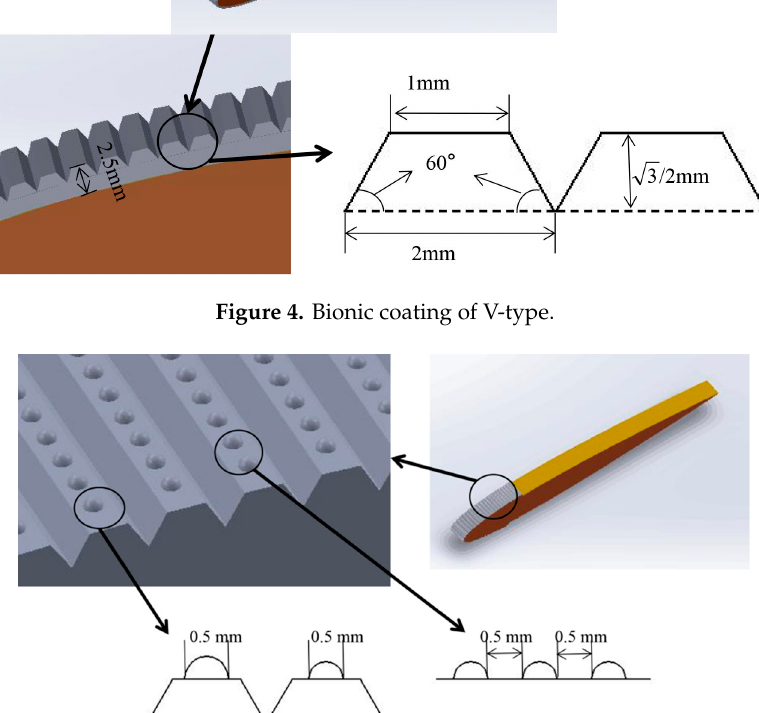
Figure 4. Bionic coating of V-type.